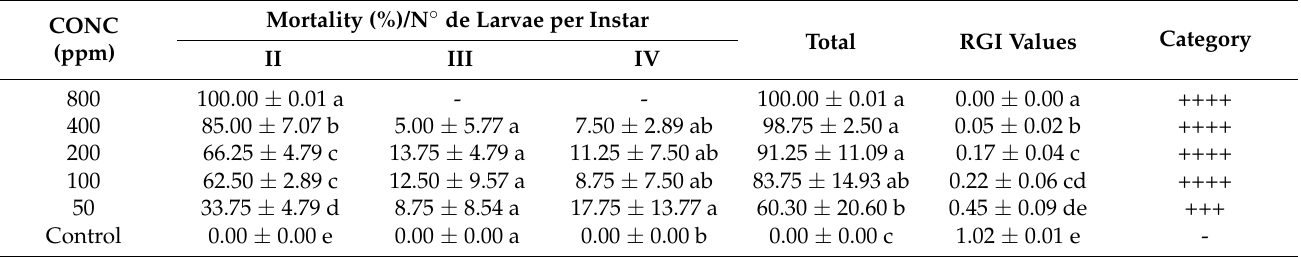
Table 3. Mortality (%) and relative growth index of the immature stages of Aedes aegypti mosquitoes treated with essential oil from Piper cordoncillo .